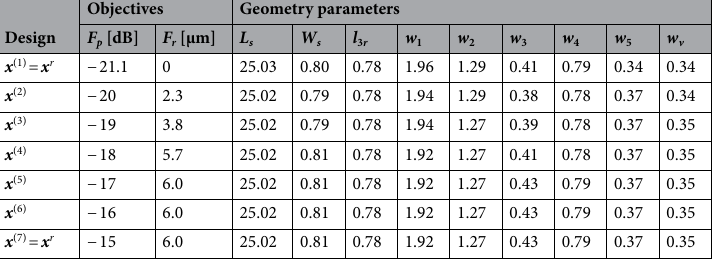
Table 3. Results of multi-criterial design with robustness evaluation for a dual-band BLC of Fig. 11.